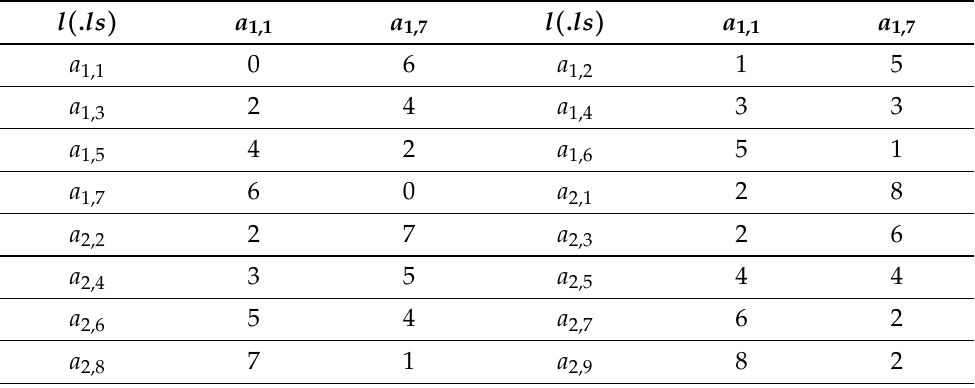
Table 1. Locations of the nodes of GHCN ( 2,2,3 ) .